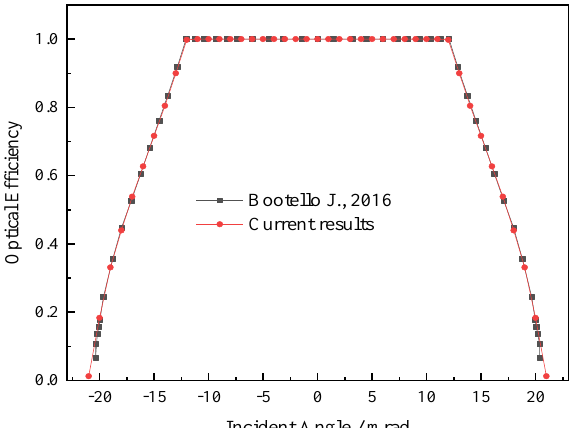
Figure 6. Comparison of optical efficiency between current model and reference [22].